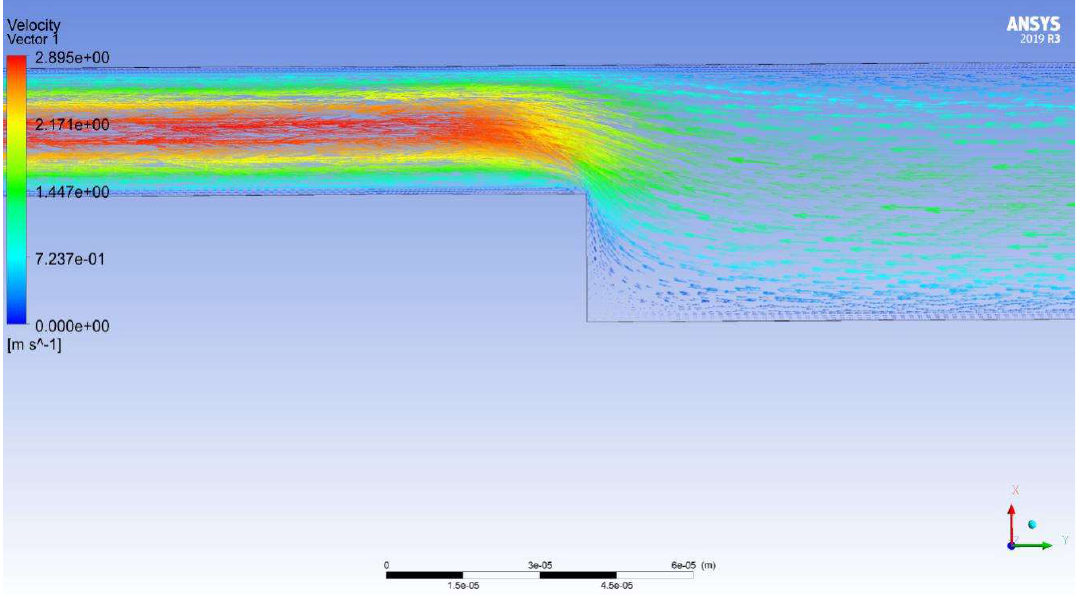
Figure 13. Velocity vector distribution in the Reynolds Stress turbulence model.